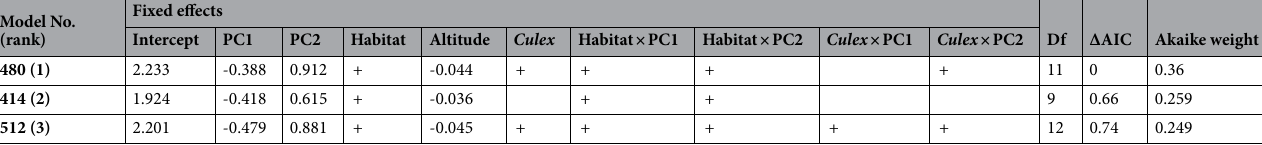
Table 3. Result of the generalized mixed linear models to explain the absolute frequency of An. coluzzii at the different breeding sites. PC1 = Principal Component 1, extracted from the results of the Principal Component Analysis (PCA); PC2 = Principal Component 2, extracted from the PCA results; Habitat = Urban gradient, with two levels: urban (Libreville, Douala and Kribi) and rural (Cocobeach and Grand Batanga); Culex = presence or absence of Culex spp . larvae; + = term significantly retained in the model; Intercept (logit scale) = fitted value for baseline factor levels. In all models, random effects are breeding sites within each